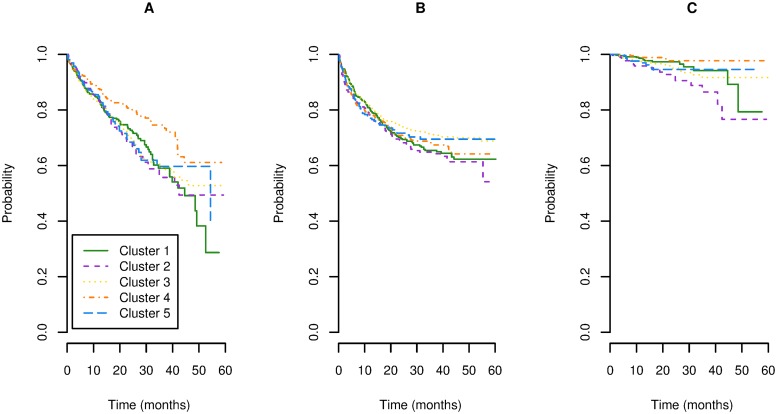
Survival Kaplan-Meier curves according to the cluster of centers. 5A. Technique failure. 5B. Peritonitis.